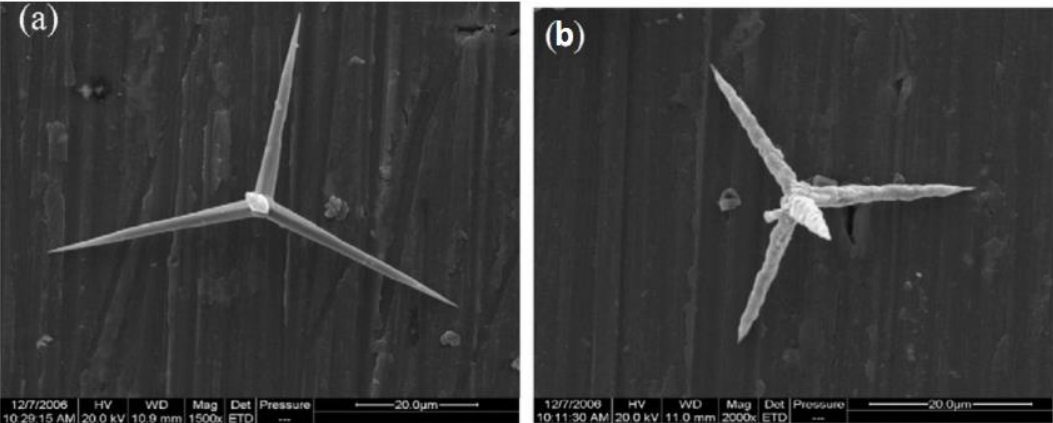
Figure 11. SEM micrographs of ( a ) an original T-ZnOw and ( b ) aT-ZnOw/PANI core-sheath structure. Images from [22].